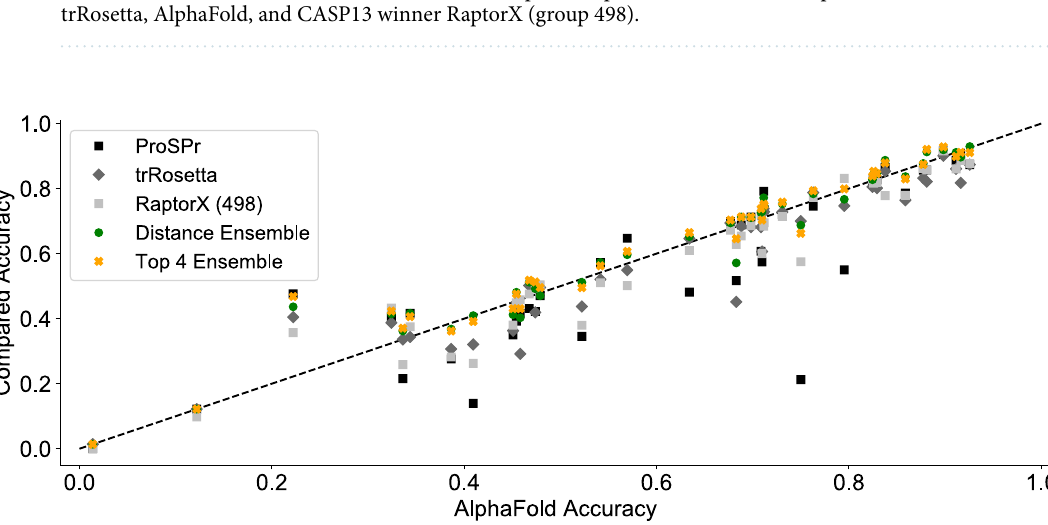
Figure 3. Scatterplot comparing accuracies of long-range contact predictions made by AlphaFold against a variety of other methods for 41 CASP13 targets, including the individual methods ProSPr, trRosetta, and Raptor X (group 498) as well as two ensembles. The Distance Ensemble combines predictions from ProSPr, trRosetta, and AlphaFold. The Top 4 Ensemble uses predictions from the top 4 individual methods—ranked by average accuracy—which are the three networks included in the Distance Ensemble, with the addition of RaptorX